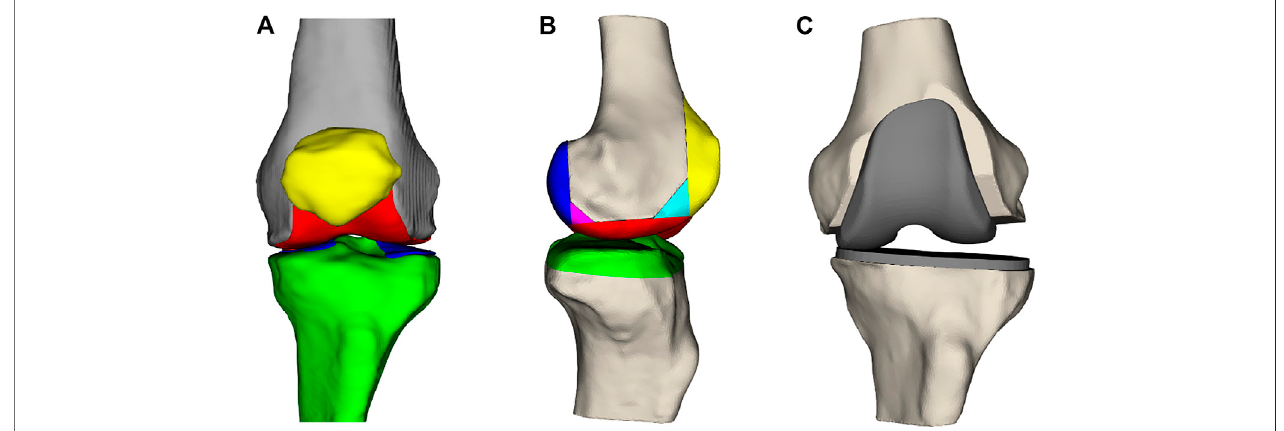
FIGURE1|(A) Frontal viewofthe femur (gray), thefemoralcartilagelayer (red), thepatella (yellow), the tibia (green), and thetibial cartilage (blue). (B) Lateral viewof the femur and tibia with theparts thatare resected during surgery. (C) Knee joint where theanterior,posterior,and distalfemoral surfacesand theproximal tibial surface have been resected and replaced by a femoral and tibial implant.